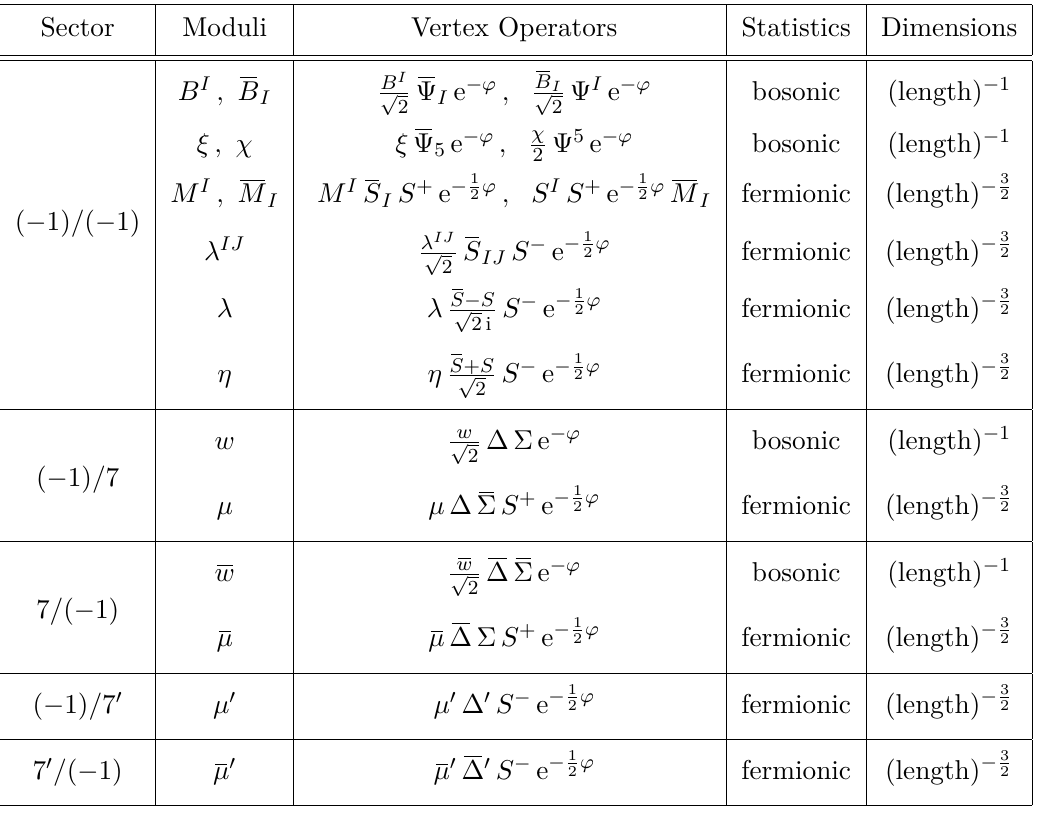
Table 2 . The physical moduli corresponding to open strings with at least one end-point on the D-instantons, and their vertex operators in the canonical superghost pictures, ( − 1) in the NS sector and ( − 1 ) in the R sector. The last two columns contain their statistics and their scaling dimensions. 2